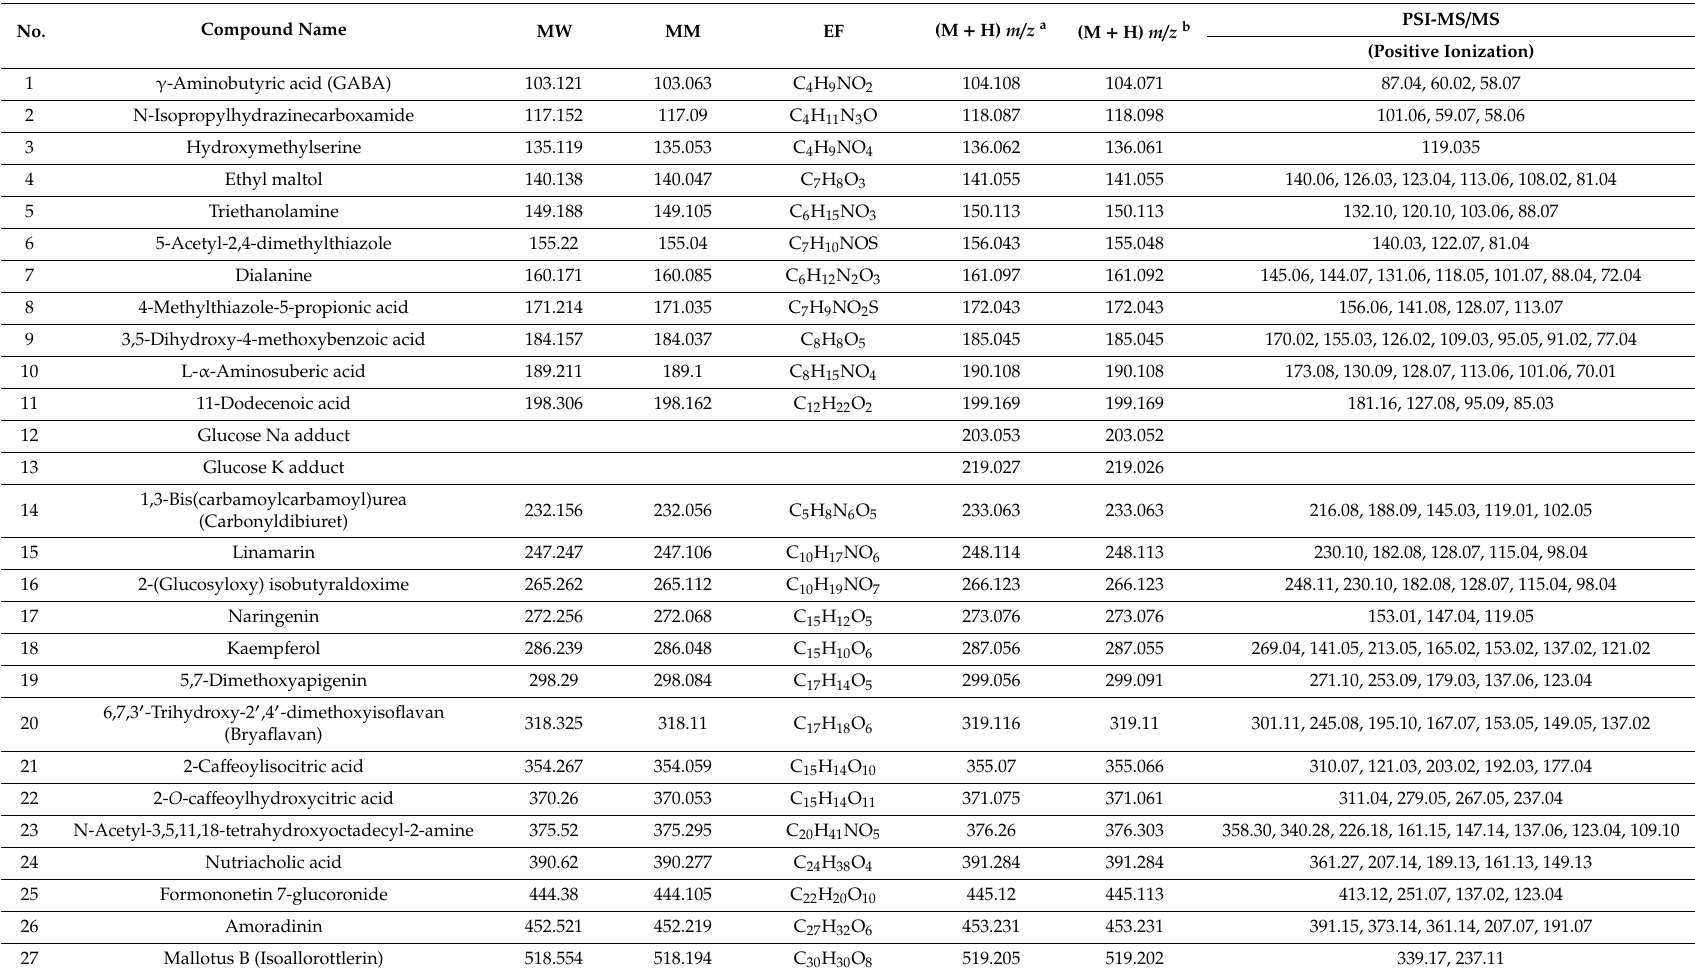
Table 1. Characterization of the secondary metabolites of DIBEt by PSI-MS /